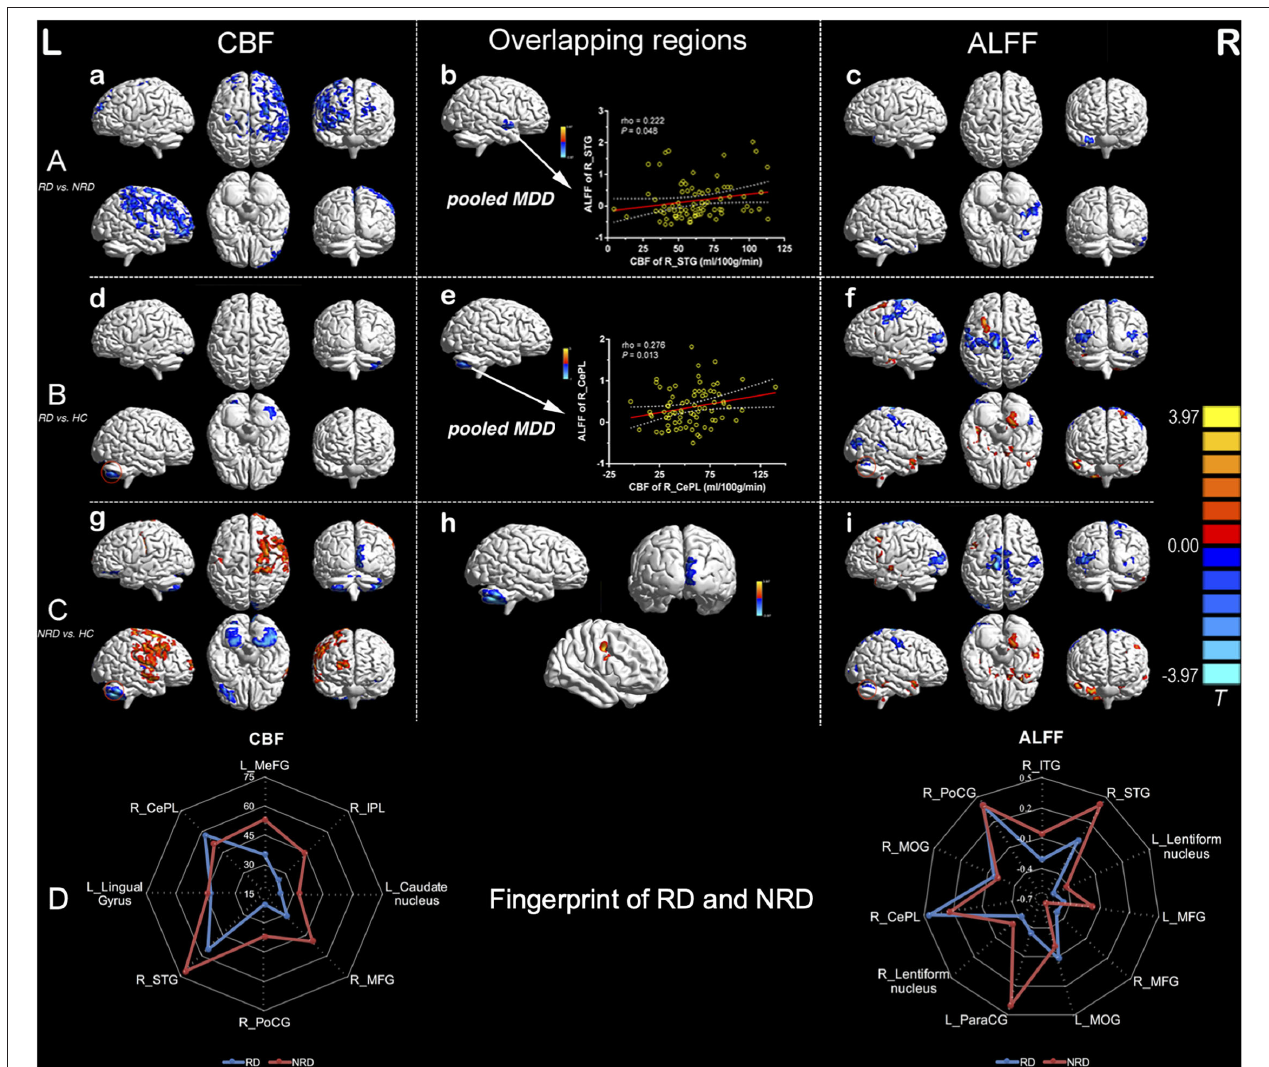
FIGURE 1 | Inter-group regional differences in CBF and ALFF and positive correlations between CBF and ALFF values of overlapping regions (R_STG and R_CePL) in the pooled depression group. Row A: differences in regional CBF (a) and ALFF (c) between the RD and NRD and overlapping regions with significant differences between the CBF and ALFF modalities in pooled MDD (b) . Row B: differences in regional CBF (d) and ALFF (f) between RD and HC and overlapping regional alterations in CBF and ALFF in pooled MDD (e) . Row C: regional differences in CBF (g) and ALFF (i) between the NRD and HC and overlapping regions of the CBF and ALFF measures (h) ; row D: the distinctive fingerprints of regional CBF and ALFF between the RD and NRD groups. The red circles in (d) and (g) indicate lower CBF and ALFF in R_CePL in both the RD and NRD groups, as compared with the HC group. The threshold was set at a corrected P < 0.05, and the T -score bar is present on the right side. CBF, cerebral blood flow; ALFF, amplitude of low-frequency fluctuation; L, left; R, right; HC, healthy controls; NRD, non-responsive depression; RD, responsive depression; STG, superior temporal gyrus; CePL, cerebellum posterior lobe.